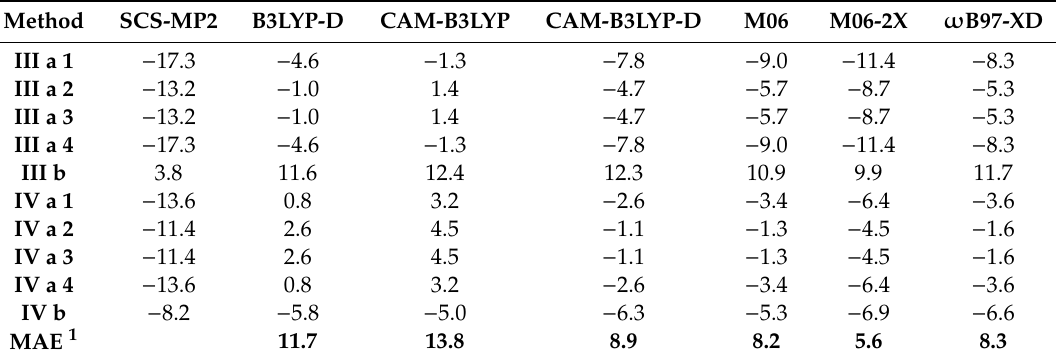
1 Mean average error with respect to SCS-MP2 averaged of all